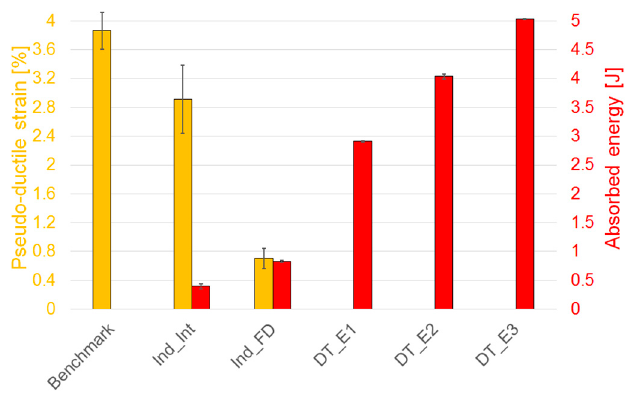
Figure 13. Pseudo-ductile strain and absorbed energy: a comparison. Benchmark (undamaged specimens), Indented Interrupted (Ind_Int), Indented Fully Damaged (Ind_FD) specimens and samples impacted respectively at 2.2 J (DT_E1), 3.2 J (DT_E2) and 4.2 J (DT_E3). Error bars represent standard deviation.